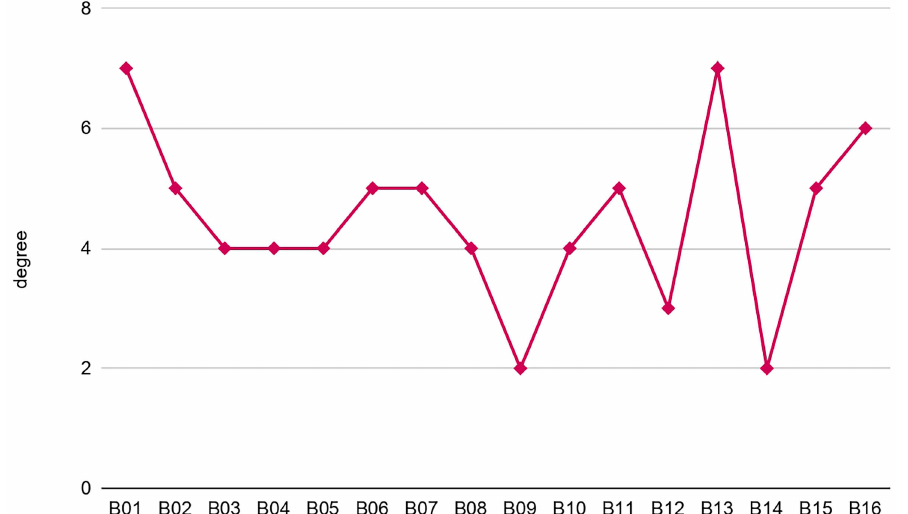
Figure 8. Degree Centrality Analysis of Barriers.